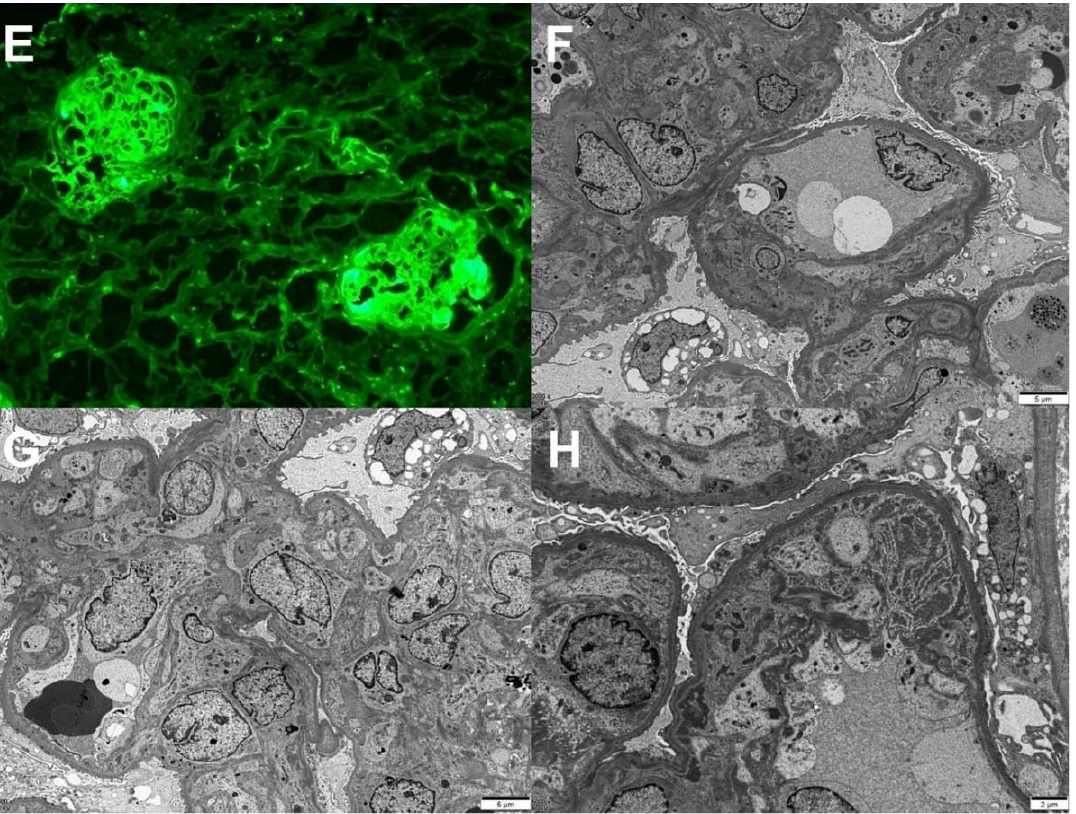
Figure 3. Pathologic findings of chronic thrombotic microangiopathy. Light microscopy: ( A ) In low magnification, no tubular atrophy or interstitial fibrosis was present (hematoxylin and eosin, ×40). ( B ) The picture shows the duplication of the capillary basement membrane (arrow) (periodic acid methenamine silver, ×400). ( C ) The glomerular lumina were occluded due to the thickening of the glomerular capillary wall with a few fibrin thrombi (arrow) (Masson’s trichrome, ×400). ( D ) Immunohistochemical stain for CD61 (platelet glycoprotein GPIIIa) shows positivity against platelet thrombi (CD61, ×400). Immunofluorescence: ( E ) Strong positive staining for fibrinogen in the glomerulus was observed(×100). Electron microscopy: ( F ) Glomerular basement membrane duplication with